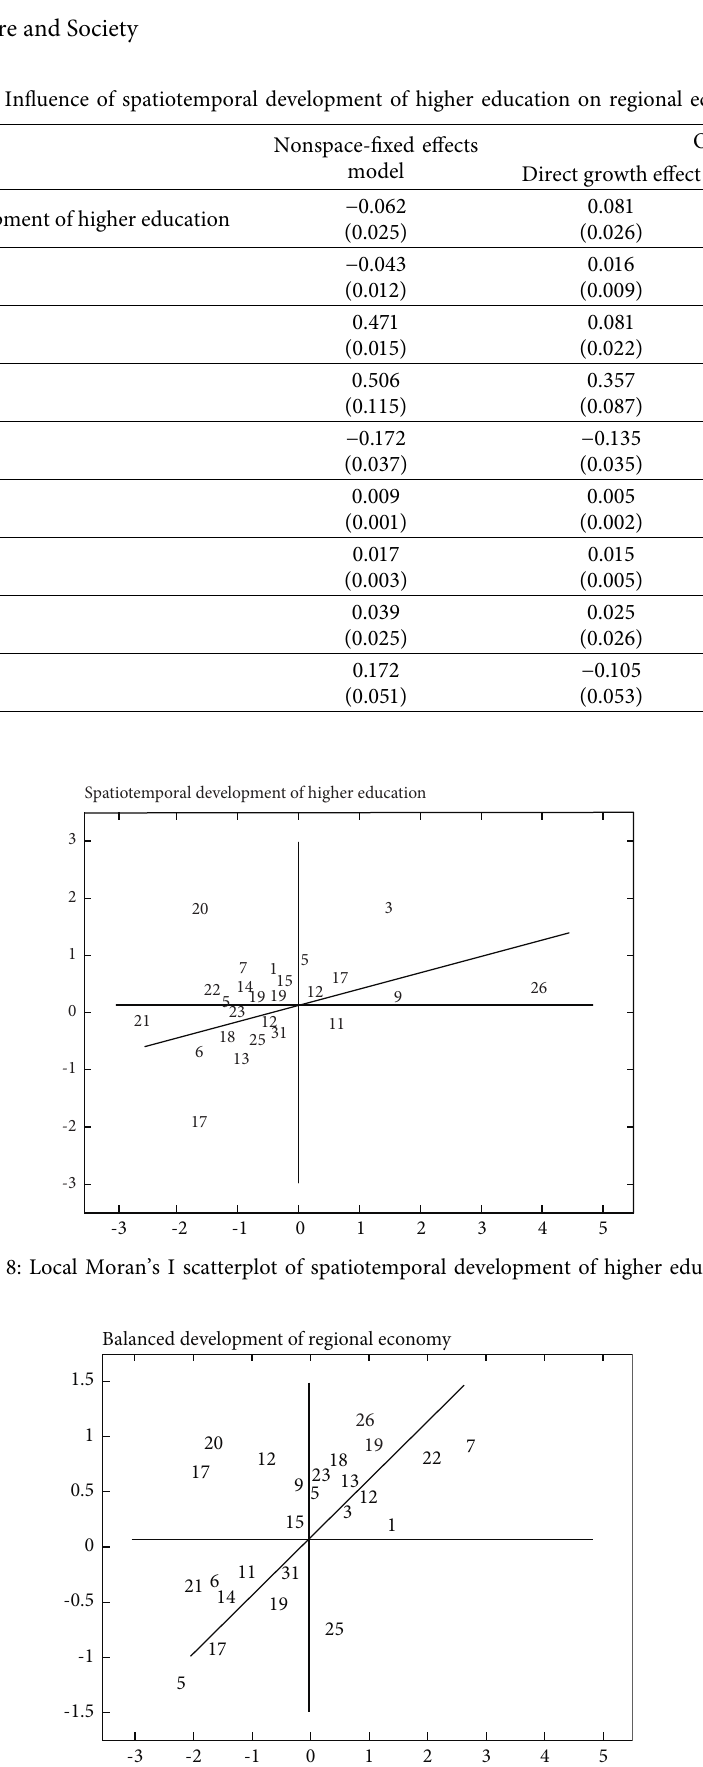
Figure 9: Local Moran’s I scatterplot of balanced development of regional